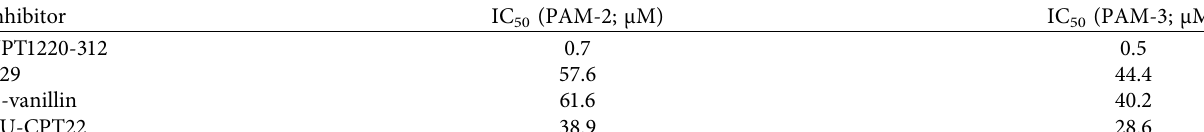
Table 1: Potencies of NPT1220-312 and other reference inhibitors of TLR2.